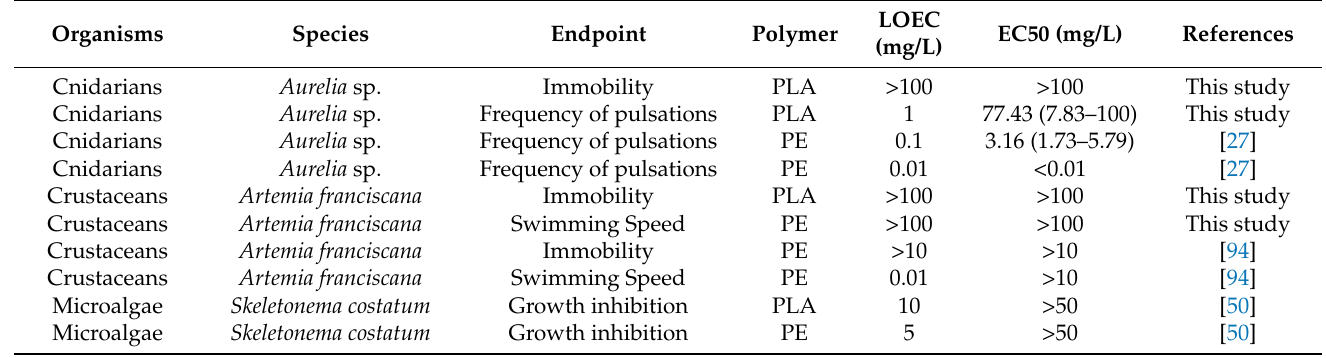
Table 1. LOEC and EC50 (mg/L) values with confidence limits reported in the literature for marine zooplankton exposed to polylactic acids (PLA) and polyethylene (PE) microplastics